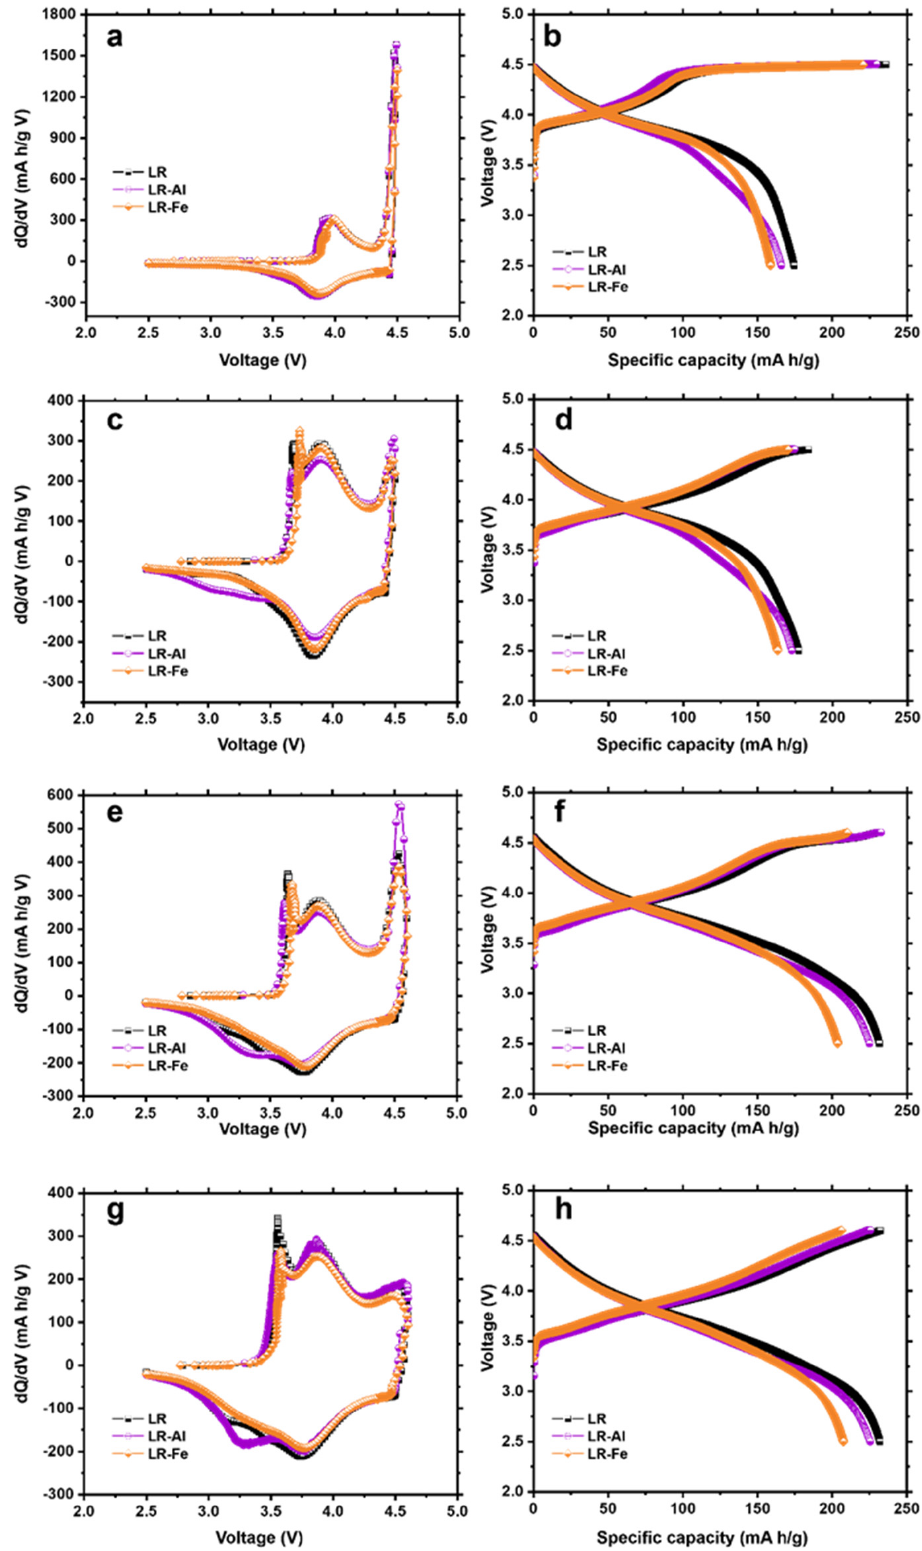
Figure 6. ( a , c , e , g ) dQ/dV plots and ( b , d , f , h ) corresponding charge–discharge curves for the 3–6 cycles in the potential ranges of ( a – d ) 2.5–4.5 V and ( e – h ) 2.5–4.6 V. Cycles 7 and 8 (Figure 7) complete the activation process. By the last activation cycle (Figure 7c), the shapes of the dQ/dV curves are similar for all the materials obtained. Char- acteristic peaks on the cathode curve at ~4.3, ~3.8, and 3.3 V are attributed to the reduction reactions of O, Ni/Co, and Mn, respectively [52]. The Mn reduction peak is least pro- nounced for the LR-Fe sample. The maximum discharge capacity (Figure 7d) was ob- tained for the LR sample (244 mAh/g), and a very close value was achieved for LR-Al (238 mAh/g). The discharge capacity value for LR-Fe is lower than that for the starting sample